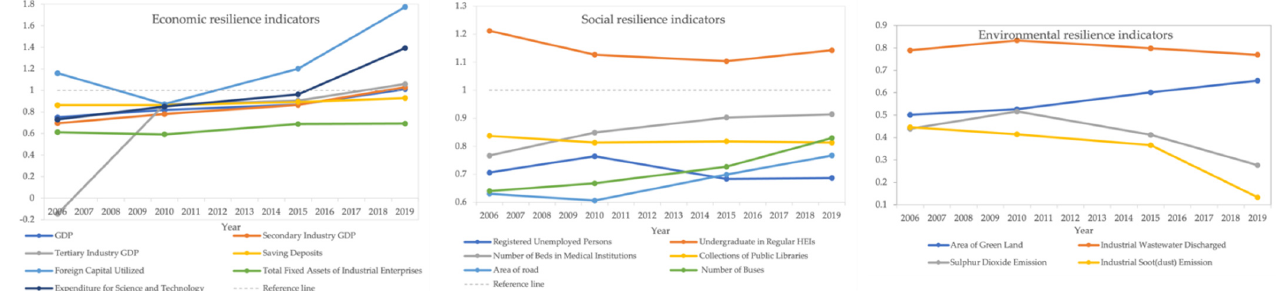
Figure 2. Temporal variation of scaling exponents of urban resilience indicators in China from 2006, 2010, 2015 and 2019.